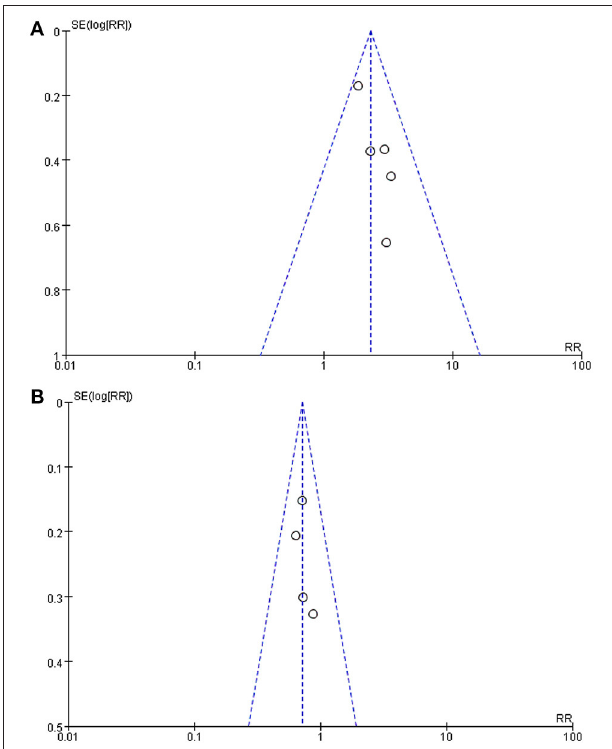
FIGURE 3 | Funnel plot of the studies. (A) Funnel plot of studies using the negative changing rate of the HUTT as the efficacy evaluation. (B) Funnel plot of studies taking syncope or presyncope recurrence rate as the efficacy evaluation. Each dot on the funnel plot represents a study, the horizontal axis represents the effect size, and the vertical axis represents the standard error. As shown in the plot, each study was close to the ideal effect value on the horizontal axis as they were evenly distributed on both sides, and each study had a low standard error on the vertical axis. SE, standard error; RR, relative